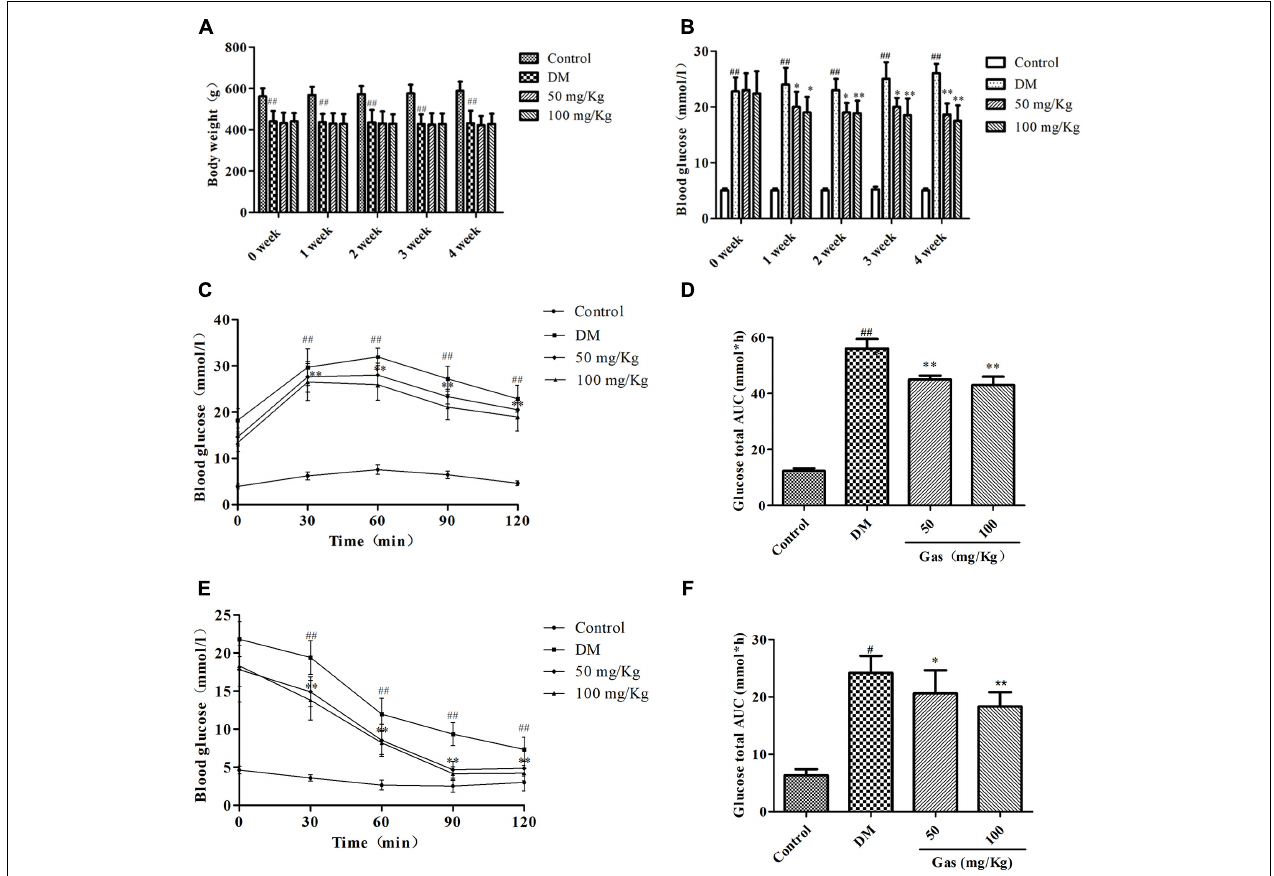
FIGURE 3 | Gas improves insulin resistance in DM rats. (A) Body weight of rats in each group during 5 weeks of treatment. (B) Fasted blood glucose level of rats in each group during 5 weeks of treatment. (C) Curve of blood glucose level in OGTTs. (D) Glucose total AUC in OGTTs. (E) Curve of blood glucose level in ITTs. (F) Glucose total AUC in ITTs. All data are expressed as means ± SD for 10 rats in each group. # P < 0.05, ## P < 0.01, compared with the control group. ∗ P < 0.05, ∗∗ P < 0.01, compared with the DM group.